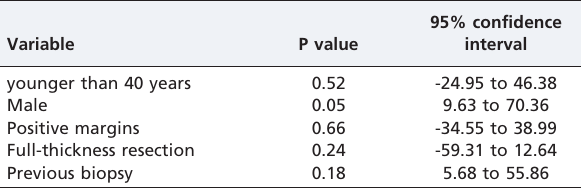
Table 2 - Variables tested for the evaluation of